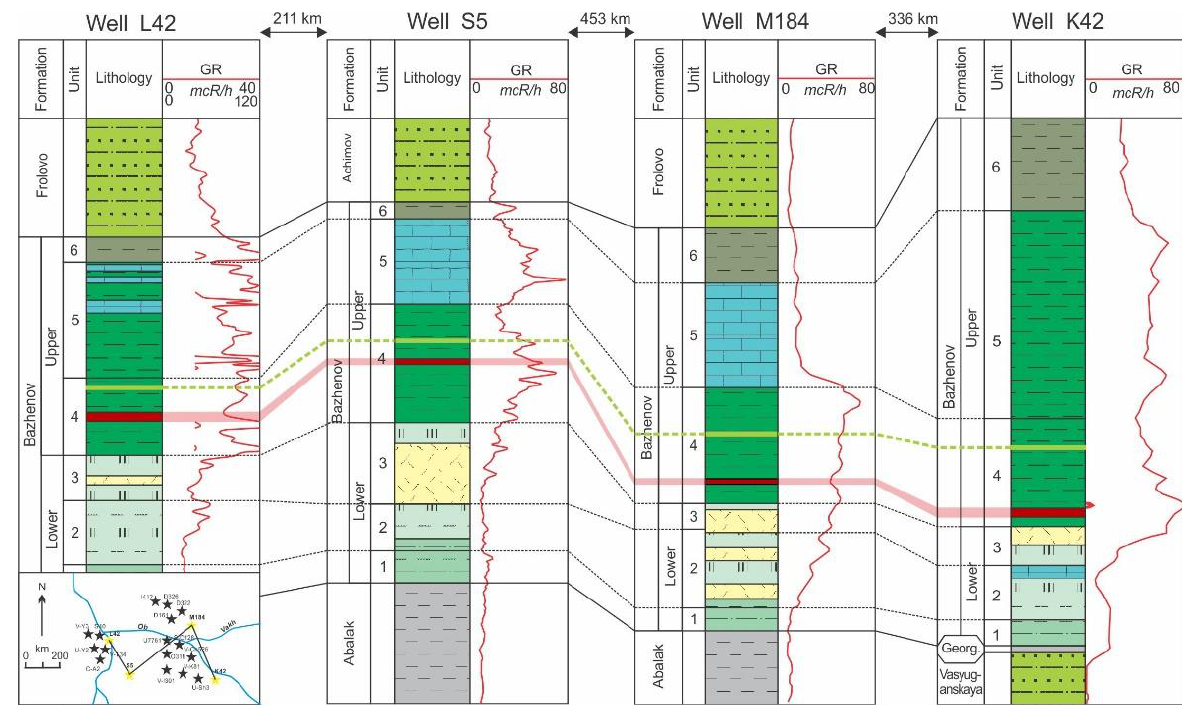
Figure 11. Stratigraphic cross-section showing the position of the alginite-rich layers (marked in red) and tuffs (marked in light green) throughout the Bazhenov sequence. Location of the well and correlation line are in the map. The legends of lithology are the same as those in Figure 2. GR, gamma-ray log.